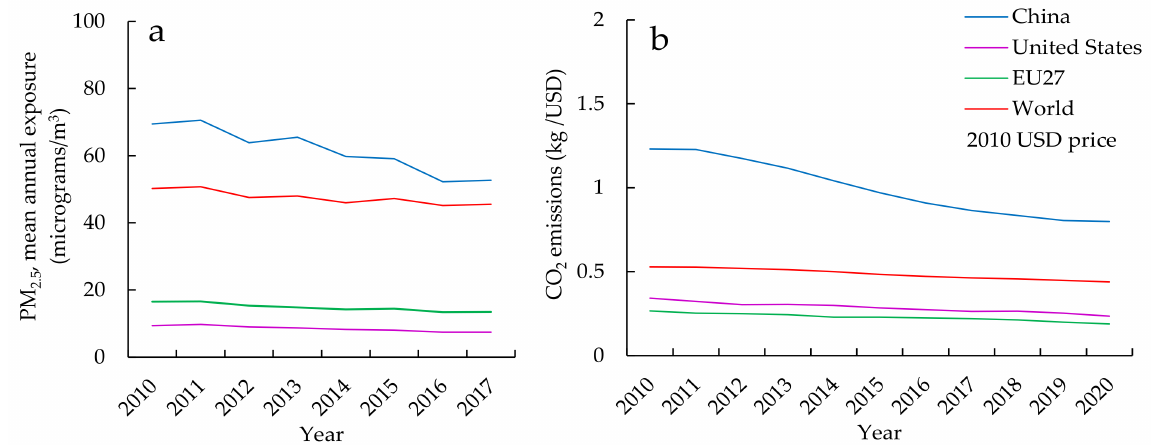
Figure 1. PM 2.5 ( a ) and CO 2 ( b ) emission levels in the world and major countries